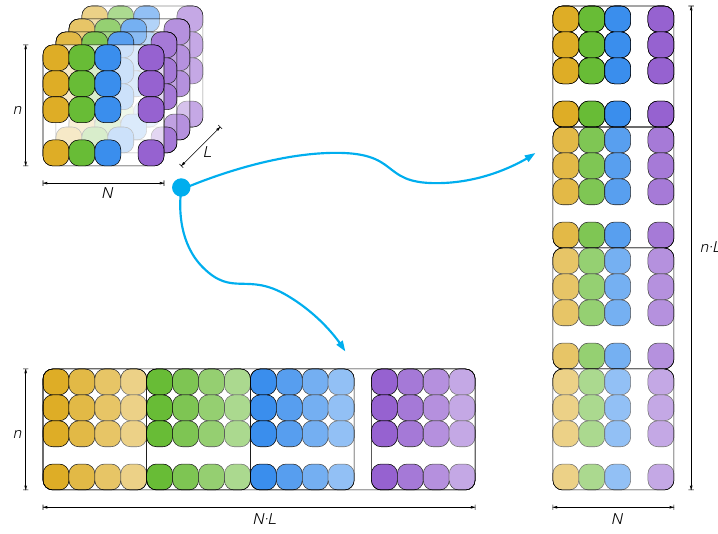
Figure 1. The three-way matrix Z can be unfolded to a two-way array in several